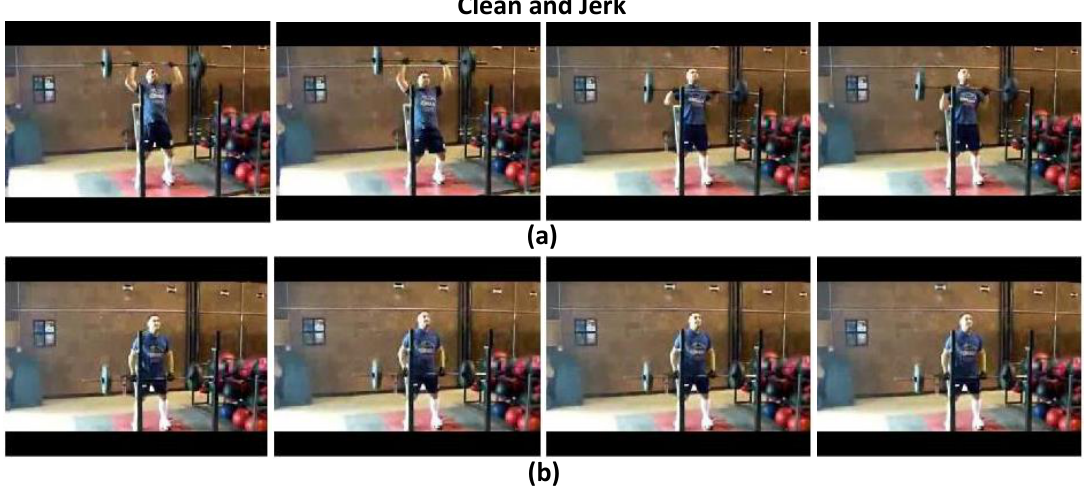
Figure 5. ( a ) The highest ranking four frames in terms of attention weights, in which the athlete is lifting the barbell. ( b ) The lowest ranking four frames in terms of attention weights, in which the athlete is putting down the